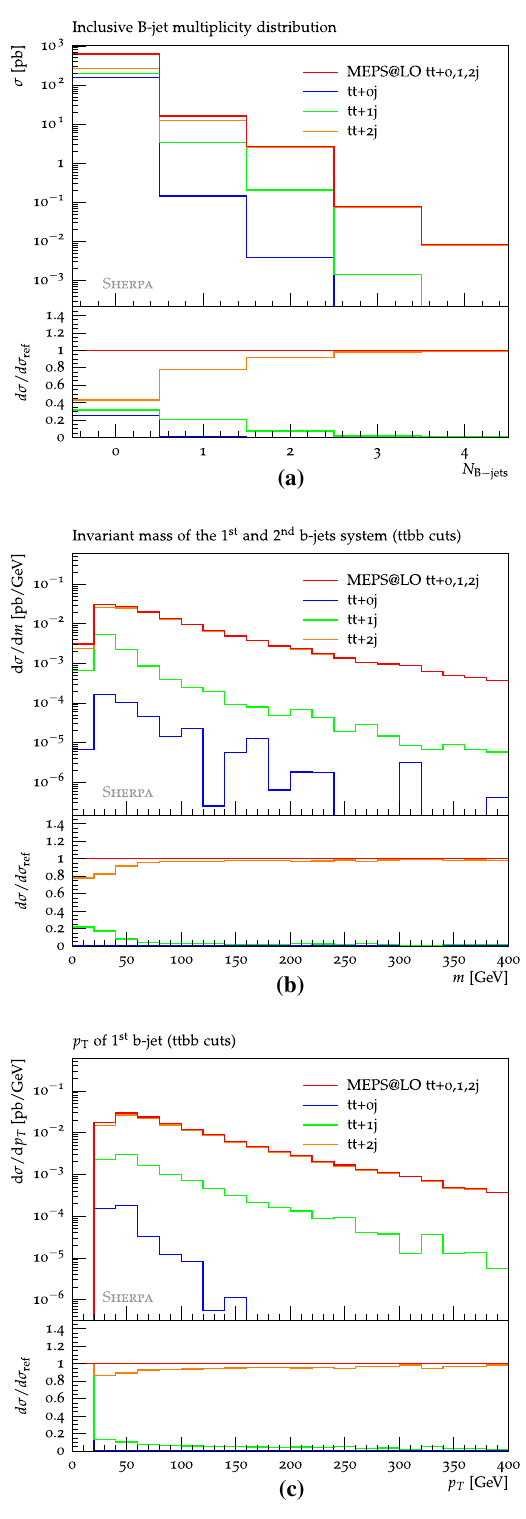
Fig. 3 Breakdown of merged LOPS simulations of pp → t ¯ t + 0 , 1 , 2jets production at 13TeV into the contributions from matrix ele- ments with t ¯ t + 0,1 and 2 generic QCD partons: distributions in the number of b -jets with p T > 25GeV ( a ), the invariant mass of the two leading b -jets ( b ), and the p T of the leading b -jet ( c